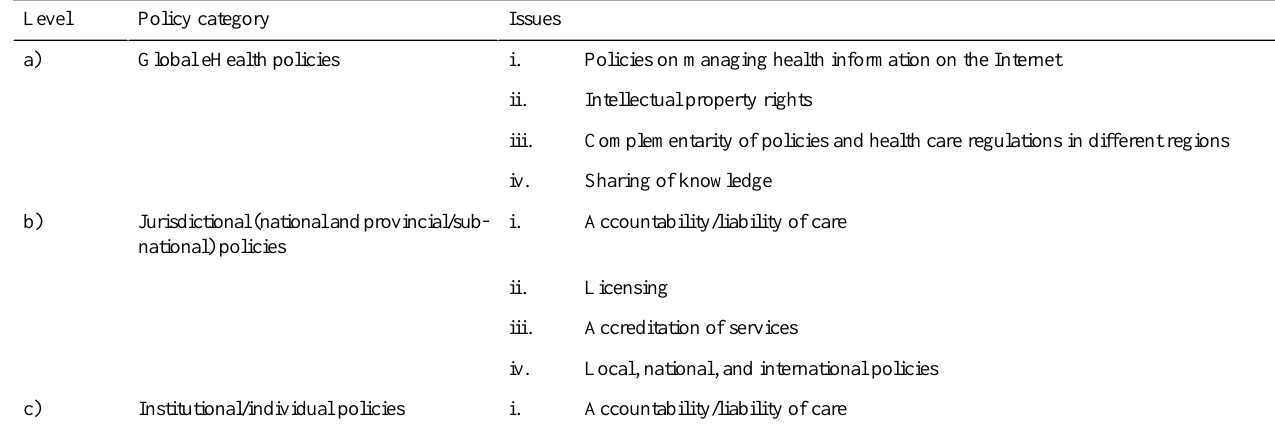
Table 2. Interjurisdictional practice.